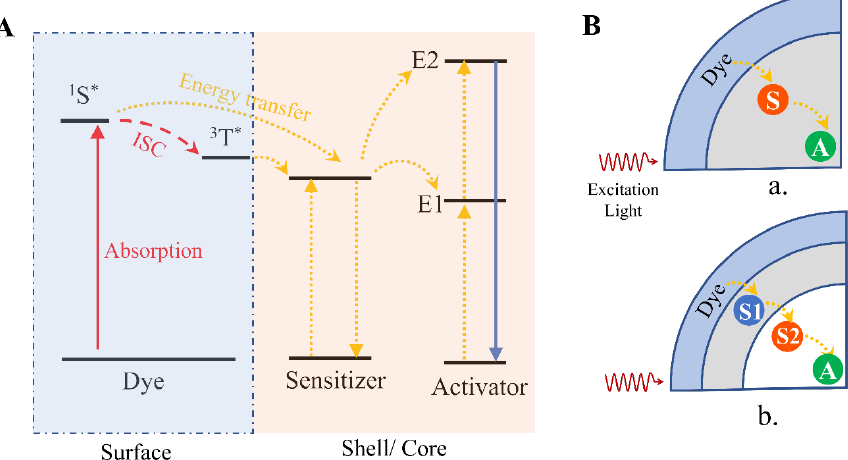
Figure 3. Dye-sensitized upconversion mechanisms and the typical structure of dye-sensitized upconversion (UC) nanostructures. ( A ) Schematic illustrations of dye-sensitized upconversion ( 1 S*: single state, 3 T*: triplet excited state, yellow line: nonradiative energy transfer, blue line: upconversion emission). ( B ) ( a ) Typical structure of dye-sensitized UC nanostructures in which only one type of sensitizer is contained. ( b ) Typical structure of dye-sensitized core/shell UC nanostructures, in which two different sensitizers were used (S: sensitizer, A: activator) (reproduced with permission from